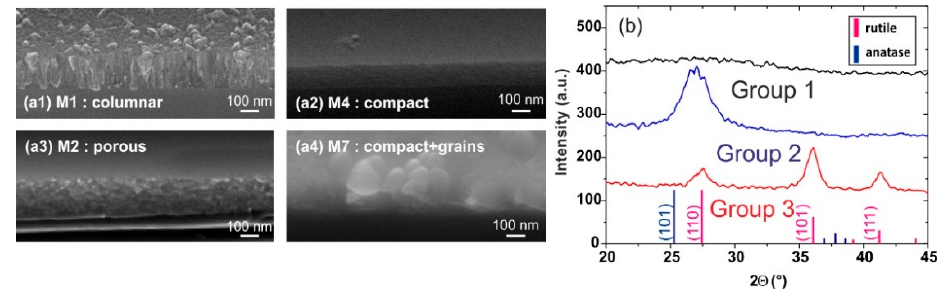
Figure 1. ( a ) SEM images and ( b ) XRD patterns obtained on TiO 2 layers, illustrating the typical morphology and crystalline structure detailed for each sample in Table 1.